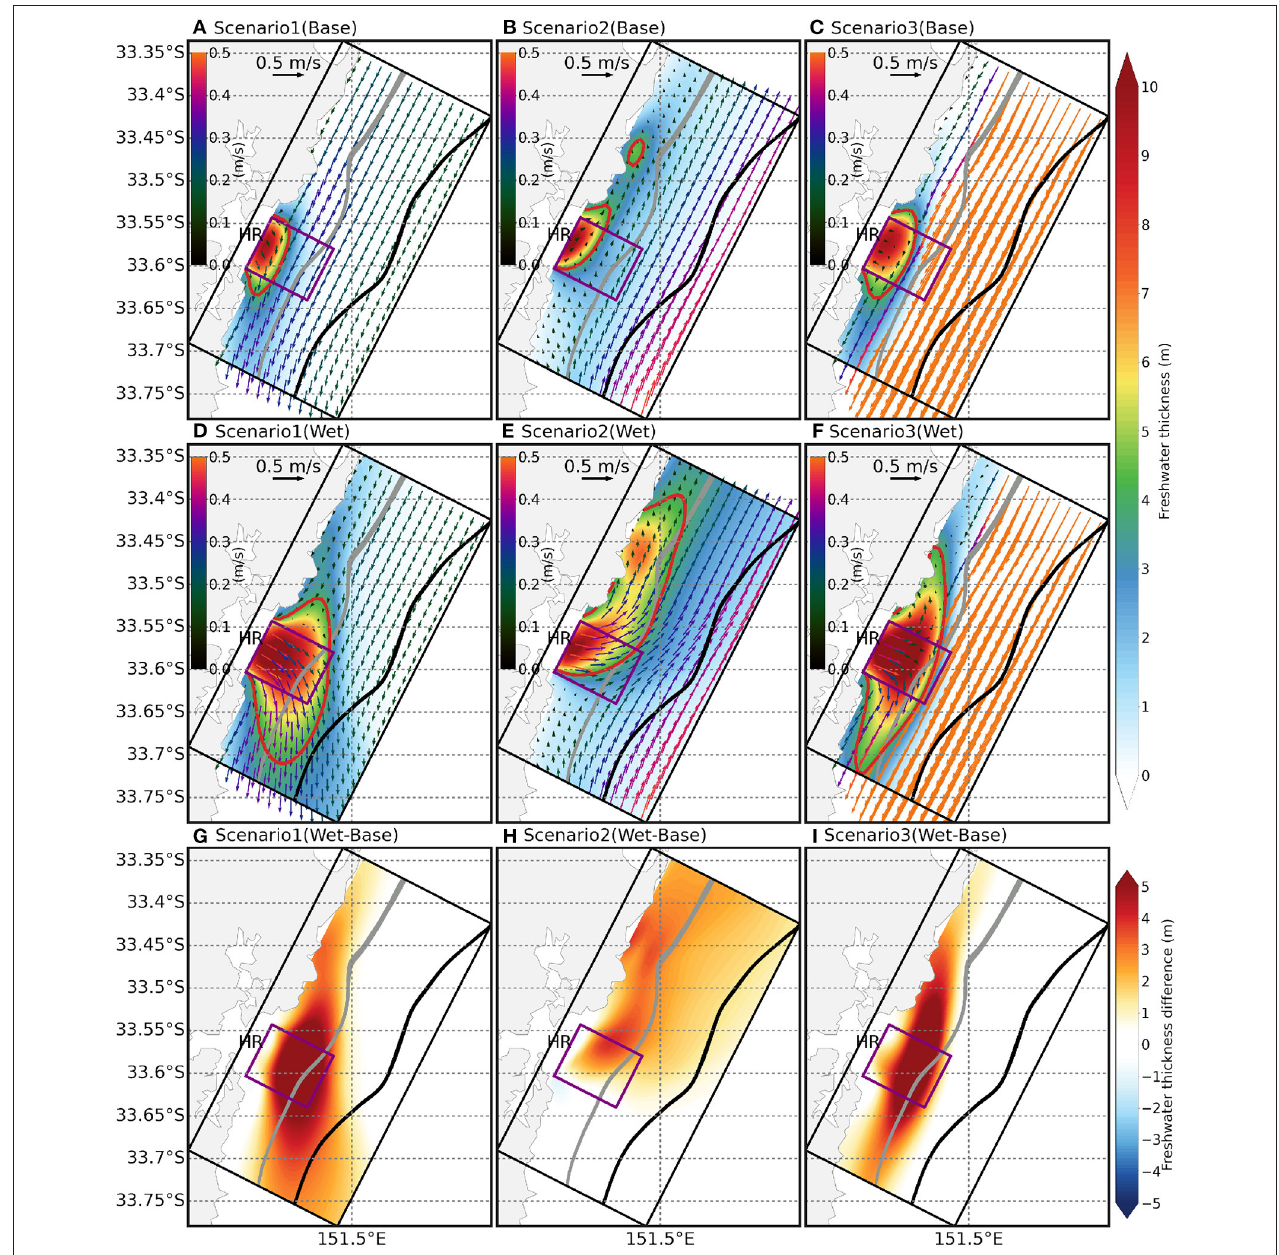
FIGURE 6 | Spatial distributions of freshwater thickness averaged over the first 4 days for each EAC scenario in the HR region and their differences between the wet event and the base case. (A–C) spatial distributions of freshwater thickness for EAC scenario 1, EAC scenario 2, and EAC scenario 3 in the base case. The solid gray and black lines show the 50 and 100 m isobath, respectively. The red line indicates the freshwater thickness contour of 4 m, and the purple box shows the location used in the following Figures 7 , 8 , 10 . The vectors show the mean surface velocities. (D–F) Same as (A–C) , but for the wet event. (G–I) Differences of freshwater thickness for three EAC scenarios between the wet event (D–F) and the base case (A–C)